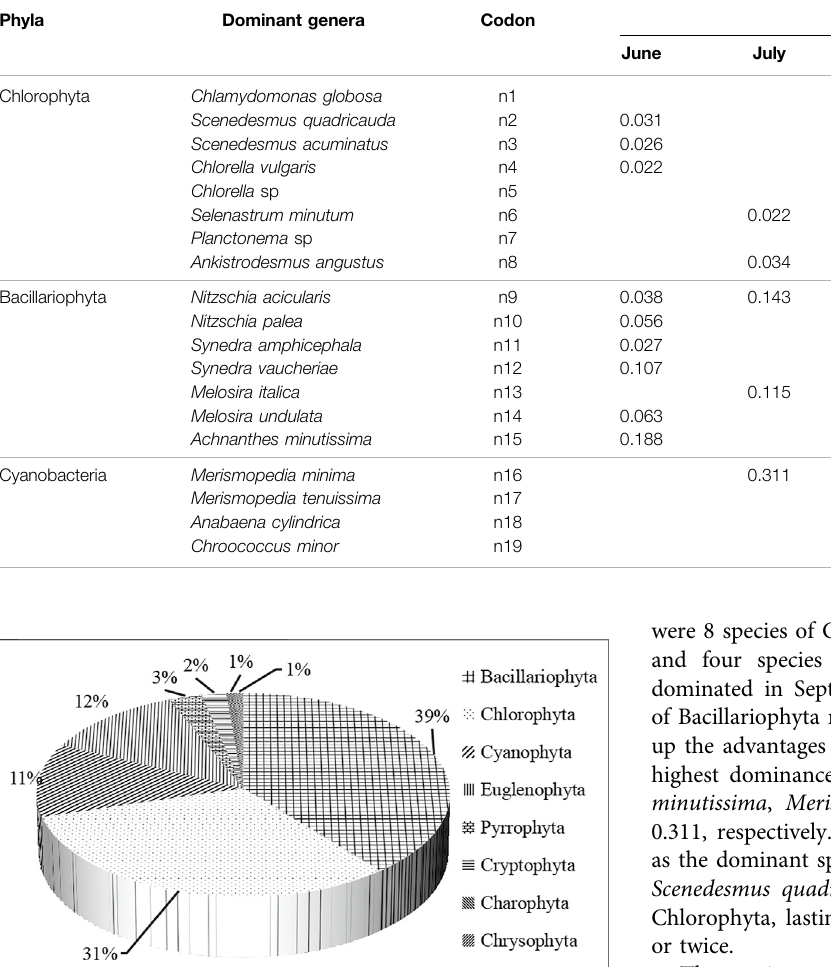
TABLE 2 | List of dominant phytoplankton species in Xinmiao Lake.